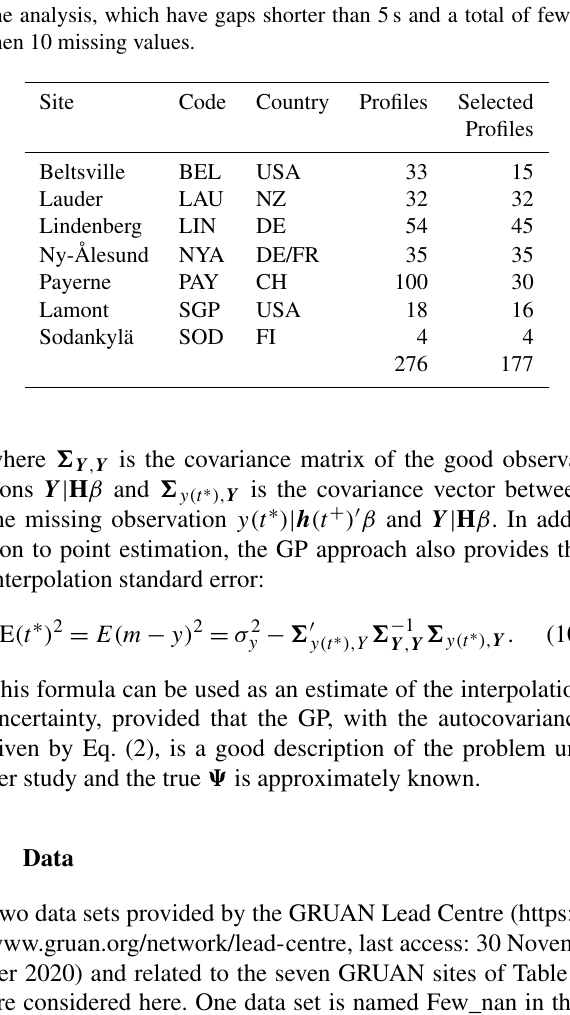
Figure 4. Linear interpolation SE, Eq. (8), as a function of the gap time for a GP with σ s = 0 . 5K, σ (cid:15) = 0 . 01K, and θ = 3s, 3min, 9min, and 30min.